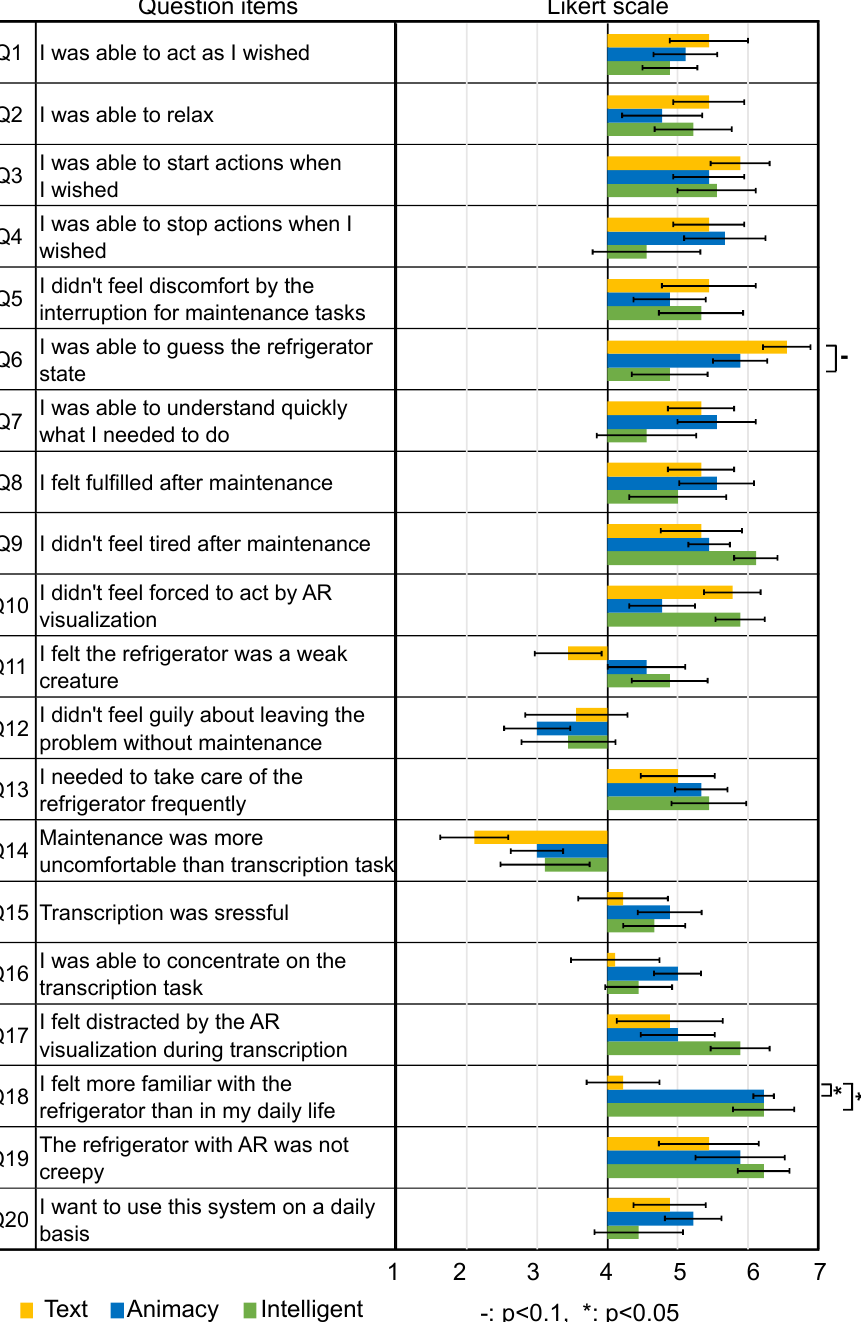
Figure 6. Results of original question